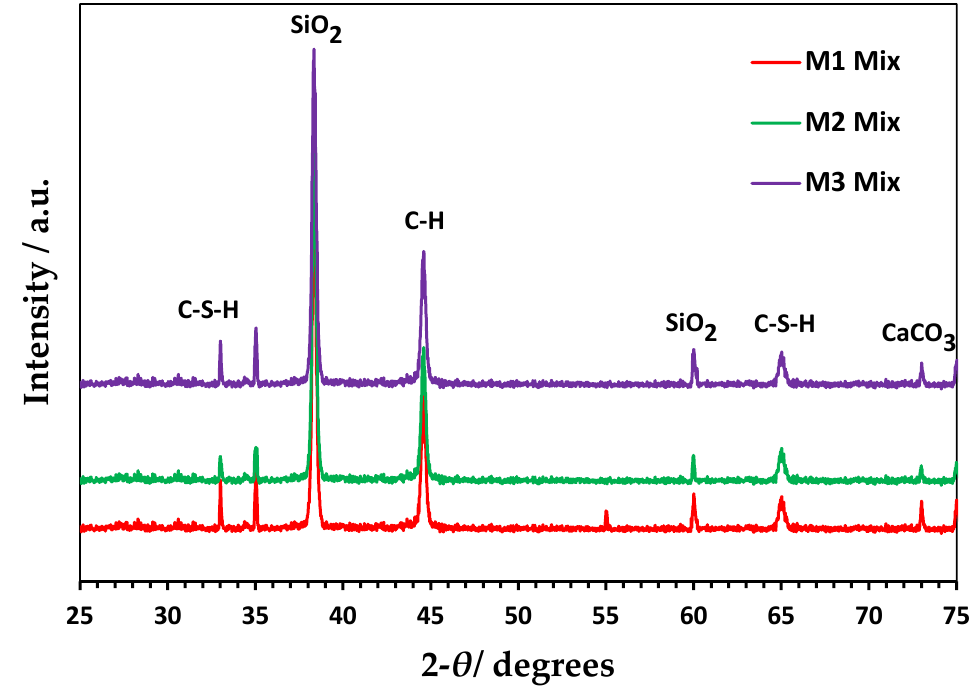
Figure 7. Comparative XRD analysis for all mixes of geopolymer G.O. concrete.